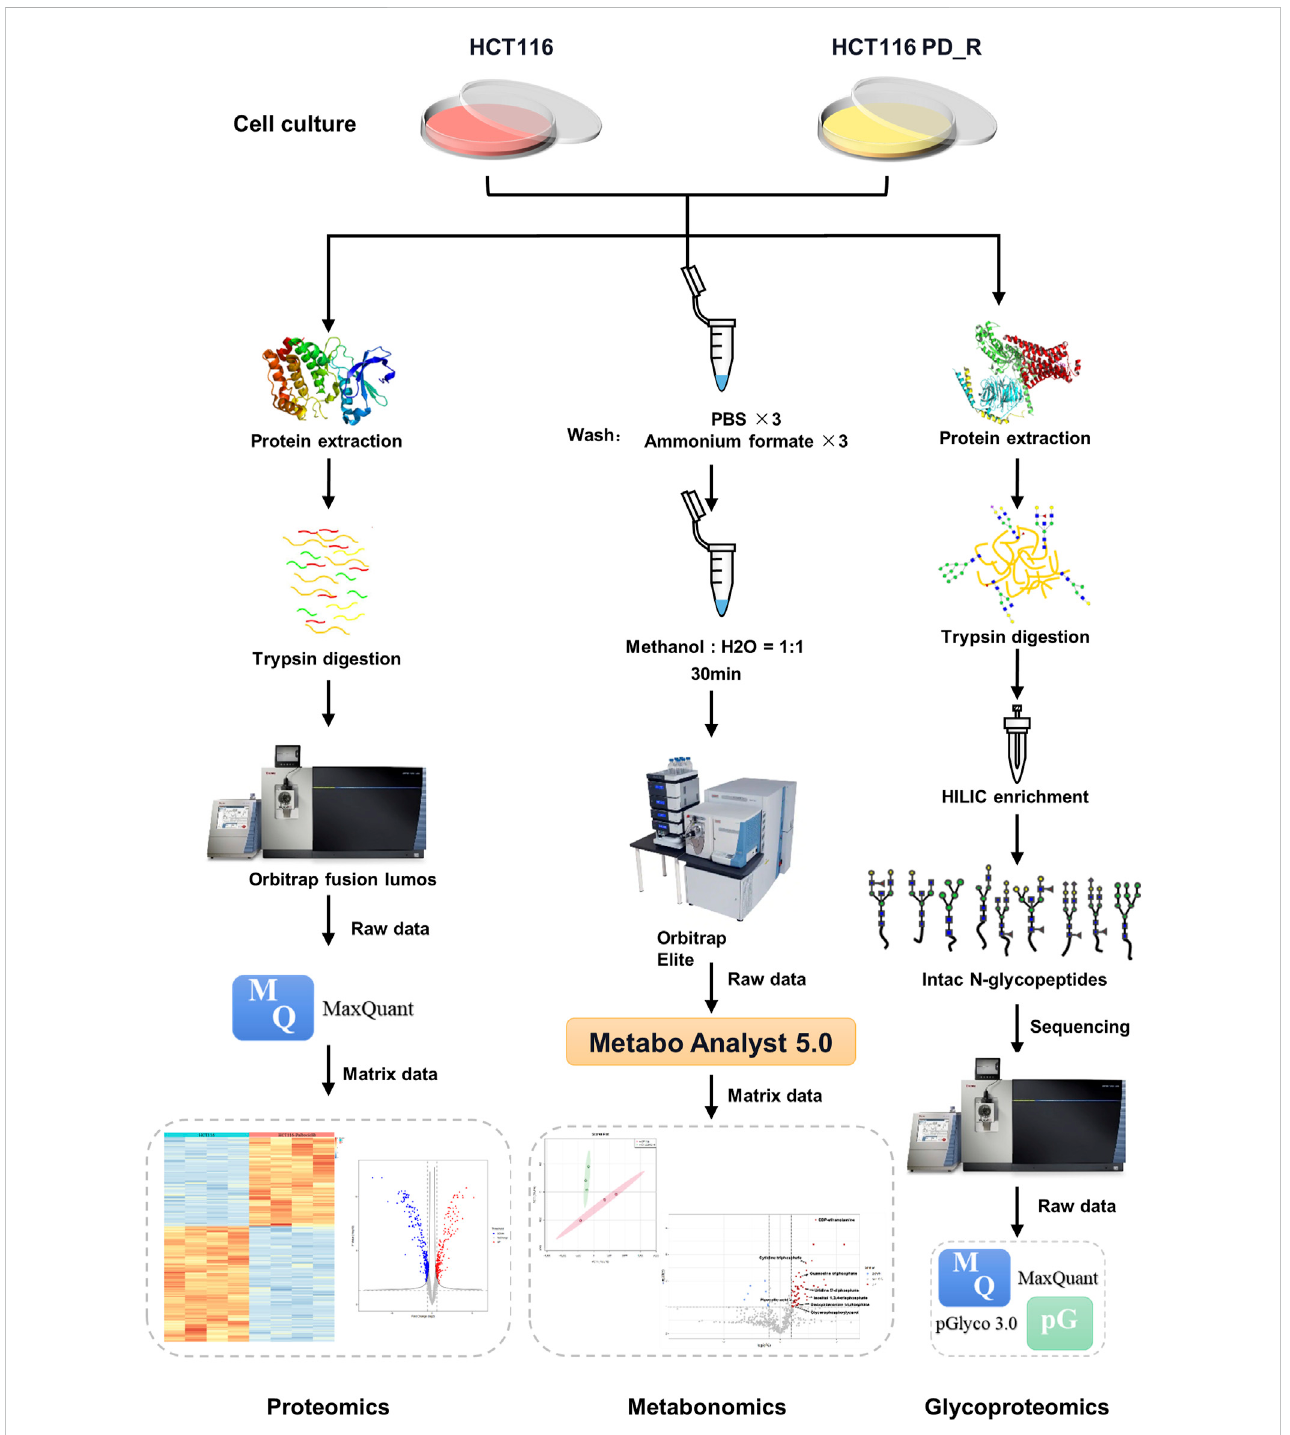
FIGURE 1 Work fl ow of LC-MS proteomics, metabolomics, and N-glycoproteomics analysis. HCT116 and HCT116 PD_R cells were collected and subjected to proteomics (left panel), metabolomics (middle panel), and N-glycoproteomics (right panel) analysis.